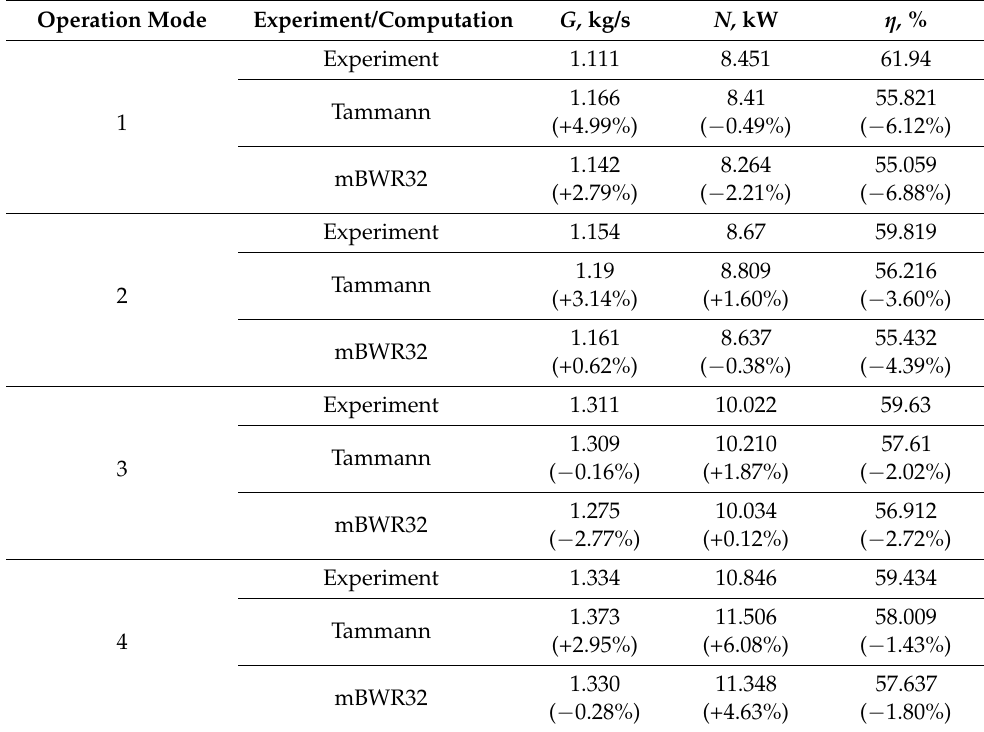
Table 9. Comparison of experimental and calculated microturbine flow rate, power and efficiency for given operational regimes, as defined in Table